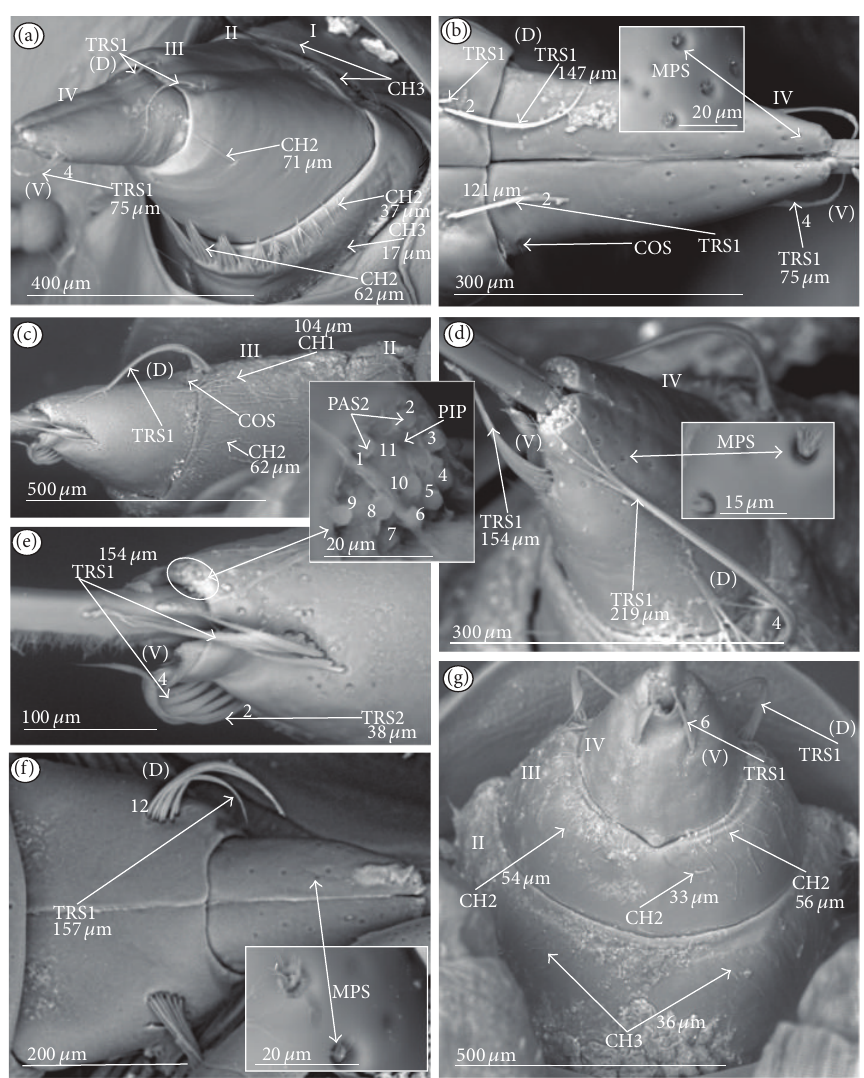
Figure 24: Types and sizes of the sensilla of the Naucoridae: Naucorinae ((a) and (b) Naucoris maculatus , (c)–(e) Namtokocoris siamensis , (f) and (g) Neomacrocoris handlirschi ). (a) CH2 are numerous and form a collar around the distal edge of the II segment on the ventral side; individual CH2 can be seen on the III segment (lateral view); TRS1 and TRS2 are visible ventrally and dorsally. (b) TRS1 (four) are distributed over the ventral side (V) in one row near the apex of the labium; MPS are less numerous and spread evenly over the IV segment (dorsal view); TRS1 (two) are distributed over the dorsal side (D), in one tuft placed distally on the III segment; COS are situated dorsally on the IV segment. (c) CH2 and CH1 are densely spread over the ventral side of the III and II segments; COS are distributed dorsally over the IV segment. (d) TRS1 (four) are distributed over the dorsal side (D), in one tuft located distally on the III segment; MPS are numerous and spread evenly over the IV segment (dorsal view). (e) TRS1 (four) and TRS2 (two) are distributed over the ventral side (V) in one row near the apex of the labium; PAS2 (no. 1–10) and PIP (no. 11) are distributed on the labial tip. (f) TRS1 (twelve) arc distributed over the dorsal side (D), in one tuft placed distally on the III segment; MPS are less numerous and distributed evenly over the IV segment (dorsal view). (g) Several CH2 are visible on the ventral side of the II segment; less numerous CH3 are present on the II and III